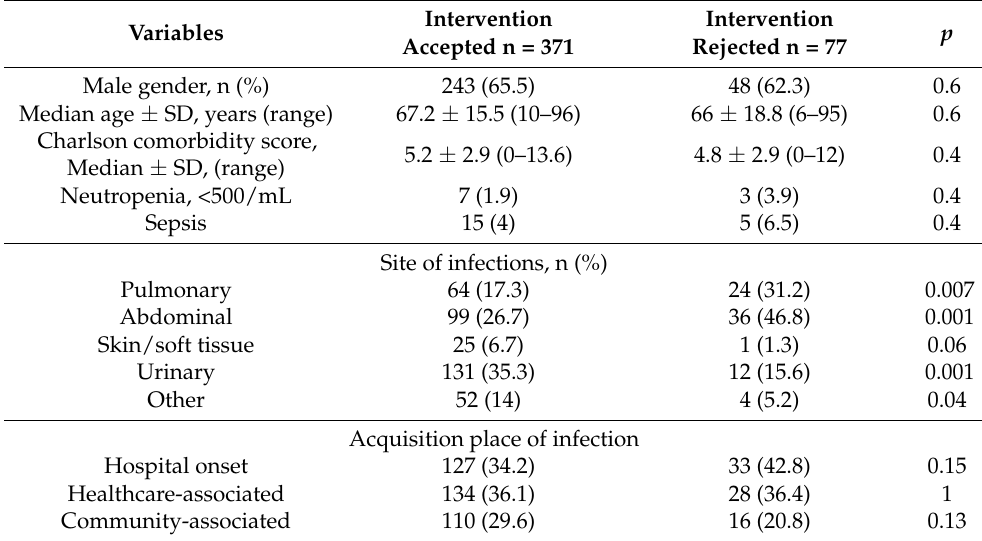
Table 1. Baseline demographic and clinical characteristics of patients with and without acceptance of ASP Recommendations. Years 2015–2019.